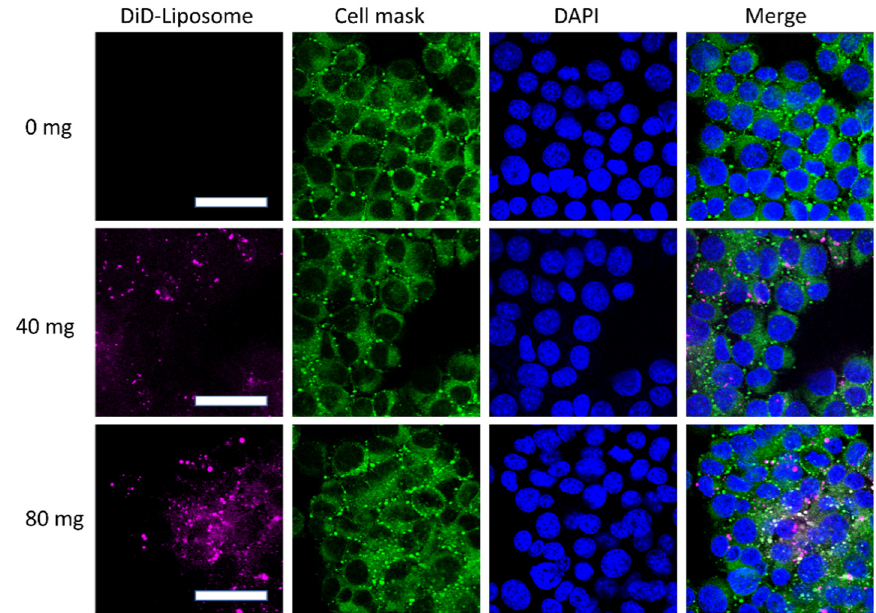
Figure 3. The internalization of the EPA-liposomes HL60 cells. The differentiated HL60 cells were treated with 100 ng/mL LPS for 3 h and incubated with DiD-stained EPA-liposomes for 30 min in the absence of FBS. Cell Mask green was used to cell membrane by incubating 15 min at room temperature. Scale bar was 50 µ m.